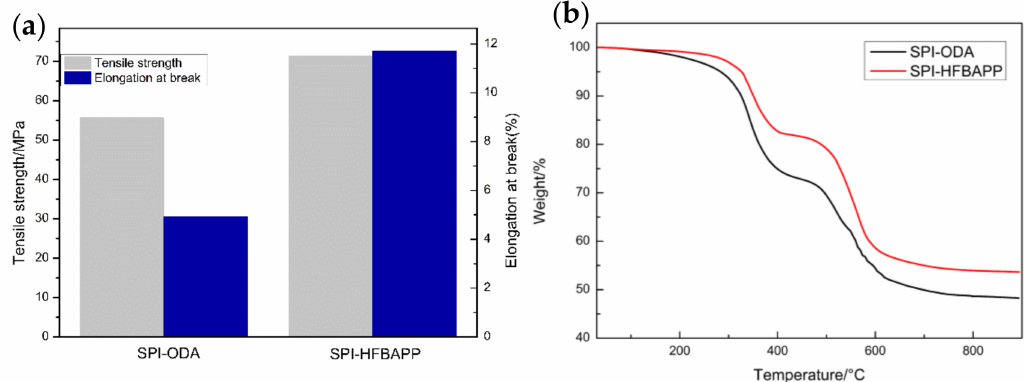
Figure 7. Mechanical and thermal stability of SPI membranes. ( a ) mechanical stability; ( b ) thermal